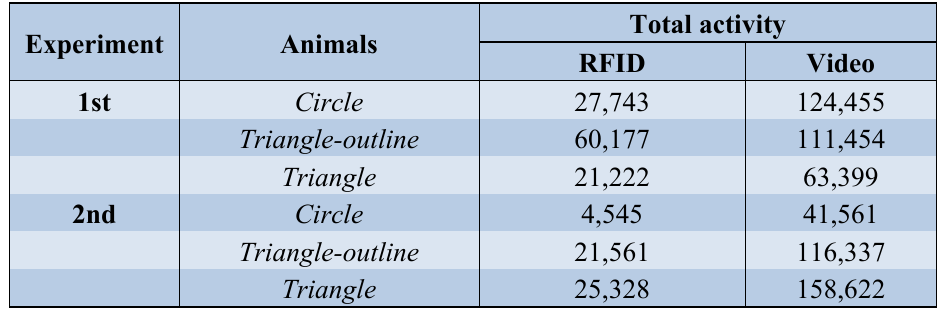
Table 2. Total locomotor activity (cm) measured using RFID and automated video imaging of three Nephrops held together in a laboratory microcosm tank during two consecutive one-week